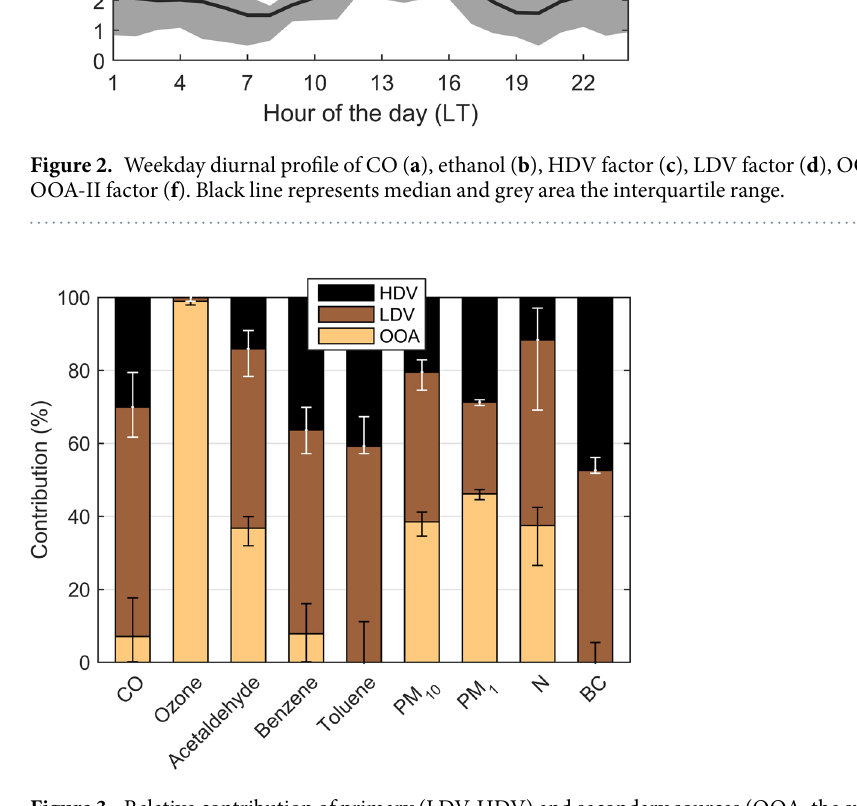
Figure 3. Relative contribution of primary (LDV, HDV) and secondary sources (OOA, the sum of OOA-I and OOA-II). Range bars represent 5 th and 95 th confidence